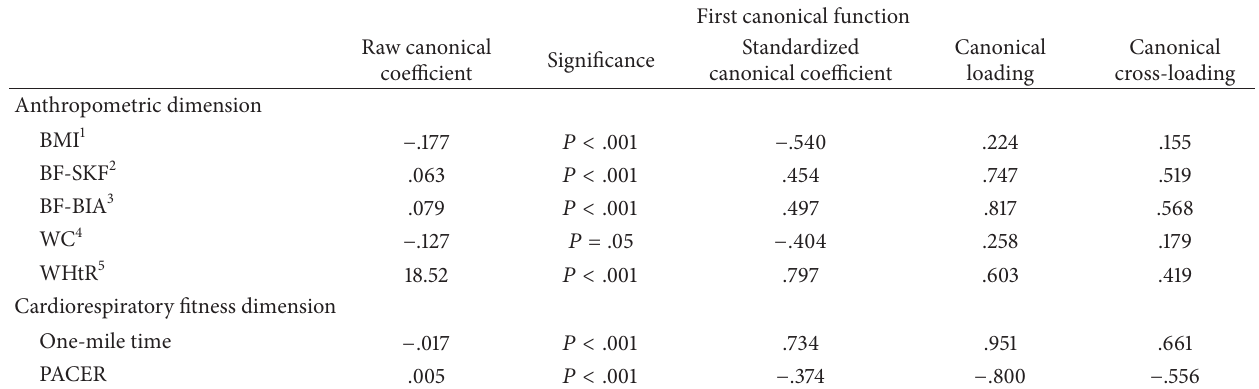
Table 3: Canonical coefficients and loadings for first canonical function.